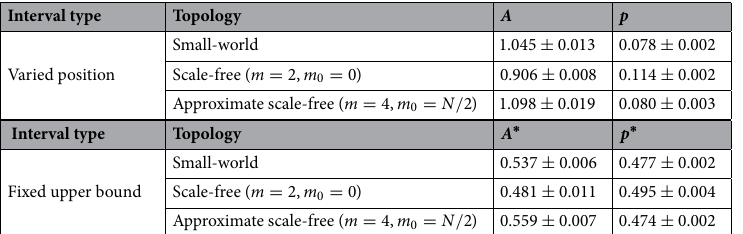
Table 2. Resulting parameter values for power-law fit of stabilization parameter over network size (cf. Eq. (3)). The upper subtable relates to the stabilization parameter µ , which means that the self-coupling strength was drawn from intervals with fixed size and varied position. The lower subtable relates to the stabilization parameter µ ∗ , which means that the self-coupling strength was drawn from intervals with fixed upper bound. Uncertainties are given by the asymptotic standard error (computed via gnuplot, cf. “Methods”). Corresponding plots are shown in Fig. 4a, Supplementary Fig. S6a (upper table) and in Fig. 4b, Supplementary Fig. S6b (lower table).